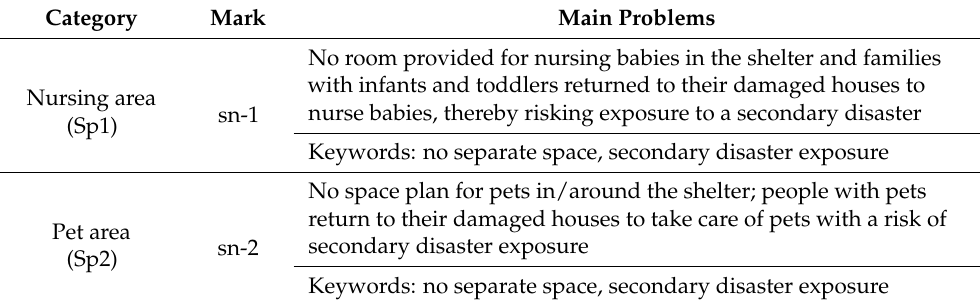
Table 8. Problems identified in the special needs zone. Category Mark Main Problems No room provided for nursing babies in the shelter and families with infants and toddlers returned to their damaged houses to Nursing area nurse babies, thereby risking exposure to a secondary disaster sn-1 (Sp1) Keywords: no separate space, secondary disaster exposure No space plan for pets in/around the shelter; people with pets return to their damaged houses to take care of pets with a risk of Pet area secondary disaster exposure sn-2 (Sp2) Keywords: no separate space, secondary disaster exposure